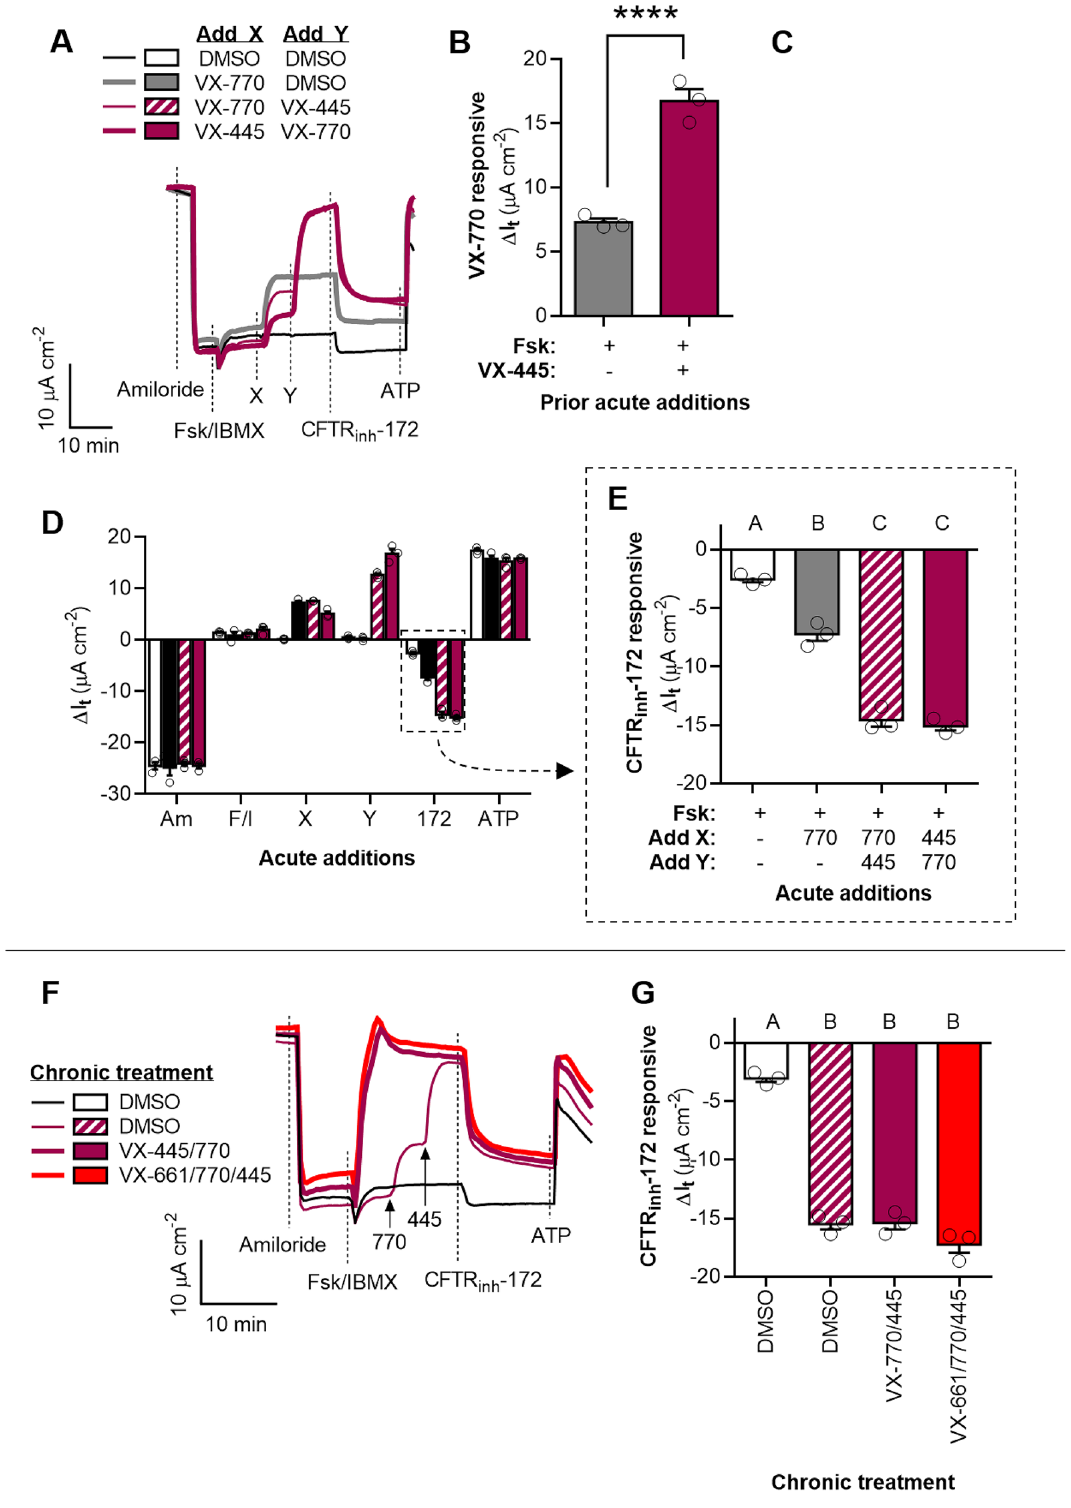
Figure 4. Synergism of ivacaftor (VX-770) and elexacaftor (VX-445) in potentiating G551D-CFTR in HNE cells. ( A ) Representative I t recordings of G551D-HNE cells showing acute actions of VX-770 and VX-445. ( B–C ) Changes in I t after acute addition of VX-770 in the absence and presence of VX-445 ( B ) and in response to the acute addition of VX-445 in the absence and presence of VX-770 ( C ). ( D–E ) Changes in I t after the additions of test compounds for the experiment presented in ( A) . G551D-CFTR mediated I t is greatest after acute potentiation by both VX-770 and VX-445. ( F ) Representative I t recordings of G551D-HNE treated for 24 h with DMSO, the double combination of VX-770 and VX-445, or the triple combination of VX-661, VX-770, and VX-445 (i.e., Trikafta). ( G ) CFTR inh -172 inhibited I t for the experiment presented in ( F) . See SI for additional experimental details and for supporting data. All data are presented as mean ± standard error. Bars with different letters (A, B, C…) are significantly different from each other (ANOVA; P < 0.05). Asterisks indicate specific P values: **** P <